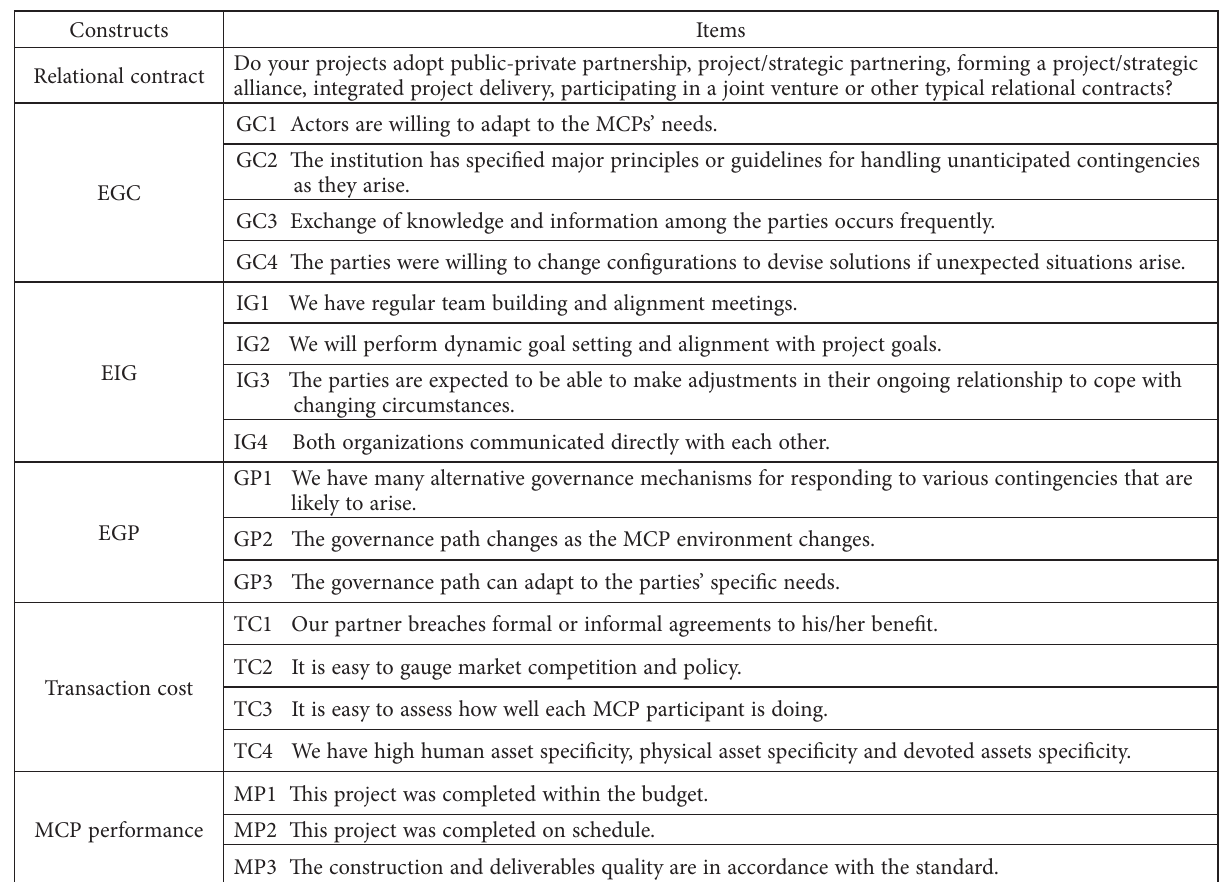
Table 2. Measures of constructs